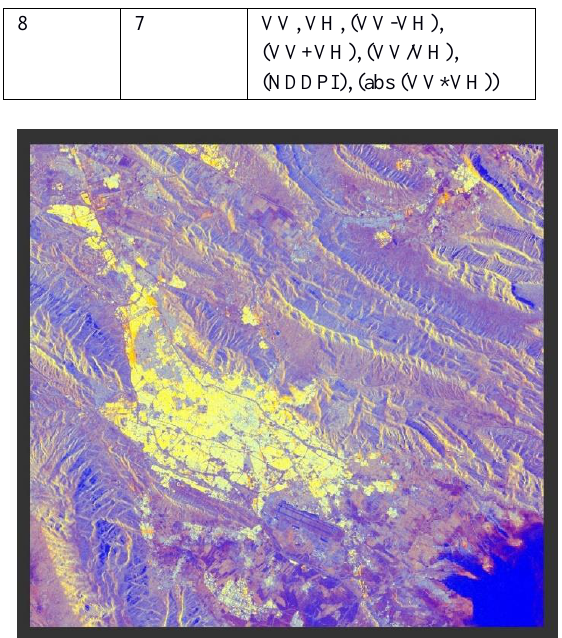
Figure 4. Dual Polarization ratio of VV+ VH of Shiraz city.